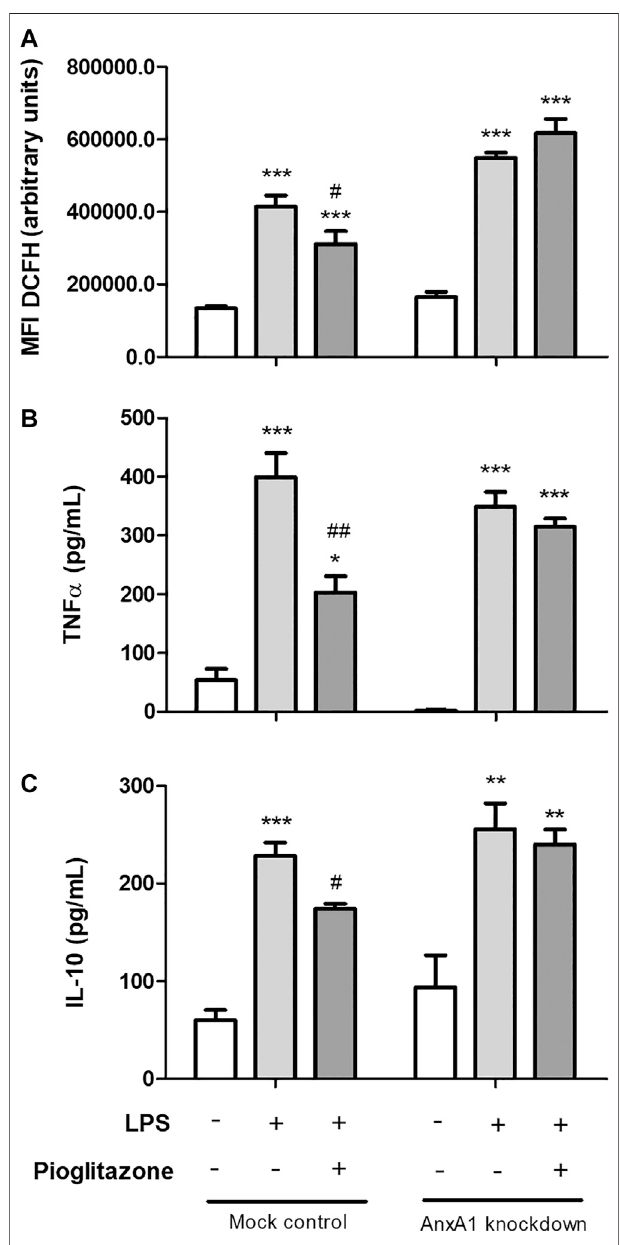
FIGURE6| Secretionofin fl ammatorycytokinesandROSproductionby transfected RAW 264.7 macrophages. Mock-transfected and AnxA1- knockdownRAW264.7cellswereplatedandtreatedwith10 µMpioglitazone for 1 h followed by 1 μ g/ml LPS for 24 h. Cells were harvested and